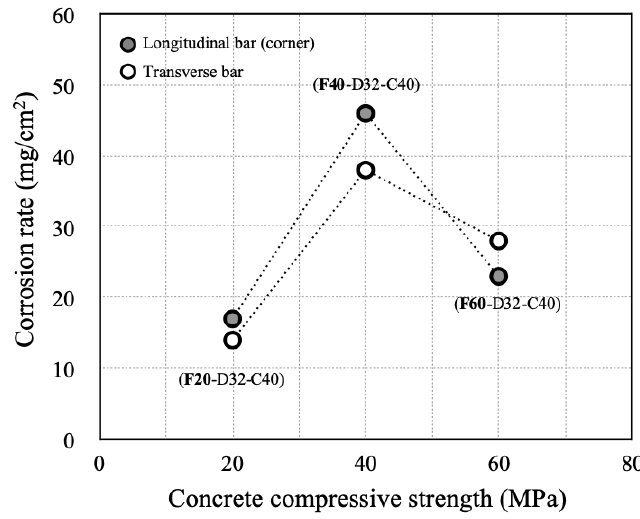
Figure 5. Corrosion rate of steel rebar according to the compressive strength of concrete. Appl. Sci. 2020 , 10 , x FOR PEER REVIEW